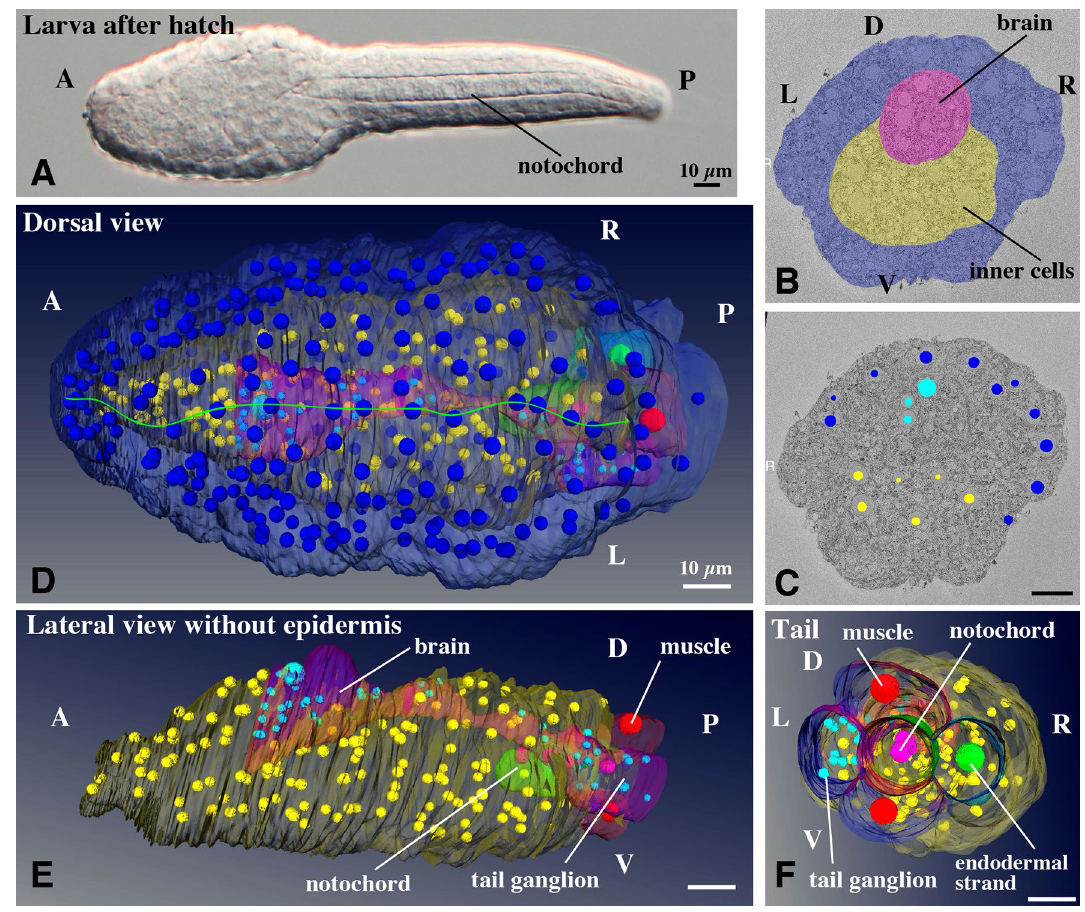
Figure 1. Structure and cellular organization of a hatched larva of O. dioica. ( A ) A larva just after hatching at 3 hpf. ( B ) Segmentation of tissue in a SBF-SEM section image. Cells facing the surface of the larva are shown in dark blue, and inner cells are shown in yellow. The central nervous system is shown in pink. Anterior view. See Supplementary Movie 1 for the entire series of serial sections. ( C ) The positions of nuclei of cells facing the surface of the larva are shown in dark blue, and those of inner cells are shown in yellow. The nuclei of the central nervous system are shown in light blue. See Supplementary Movie 1 for the entire series of serial sections. ( D ) 3D reconstruction of serial SBF-SEM sections of a hatched larva. Dorsal view. The full trunk and base of the tail are shown. The central nervous system is shown in pink with light blue nuclei. Green line indicates the dorsal midline. Note that the size and shape of nuclei do not refect those in the sample and are represented by arbitrarily-sized spheres to show the position and number of nuclei. The nuclei of the surface cells are arranged in bilateral symmetry. See Supplementary Movie 2 for the rotating 3D image. ( E ) Lateral view without epidermis. See Supplementary Movie 3 for the rotating 3D image. ( F ) Posterior view of the tail. The tail ganglion is present on the left side. ( B – F ) The images were generated using the Amira software package (ver. 5 and 6). A, anterior; P, posterior; D, dorsal; V, ventral; L, left; R, right; Scale bars, 10 S1), and connected to the tail ganglion, which was present on the left side of the tail base. Most of the inside of the trunk was filled with inner cells (yellow). A clear bilateral symmetry in the arrangement of inner cells, as well as that of the nervous system, was not observed. The cell count in the trunk region of the larva shown in Fig. 1A was 501 and is summarized in Table 1. Cell counts in a whole body in the previous study 6 is also shown in Table 1 for comparison. Previously, transmission electron microscopy (TEM) has been used to observe hatching larvae 6,15 . Especially, Stach et al., (2008) made a complete series of sections of a newly hatched larvae, observed it with TEM, segmented tissue boundaries, marked positions of nuclei in the nervous system, epidermis, notochord and muscle, and reconstructed 3D anatomy of the trunk and tail [mainly shown in the Supplementary Figures of the reference 6]. The observations of Stach et al. and us coincide well. They also distinguished three kind of cells, epidermis cells, cells in nervous system, and inner cells (designated endoderm in the anterior region and undifferentiated meso-/ endoderm in the posterior region although the boundary of these two was not clearly defined). We were not able to determine anterior border of the central nervous system based on a smooth outline of the tissue as mentioned above. In contrast, Stach et al. demarcated the anterior border based on cellular positions and smaller cell size. Therefore, cell counts in the brain region is 46 in Stach et al. and 28 in the present study. Another difference is that they observed small cavities in the center of both the nervous system and endoderm. We did not see such